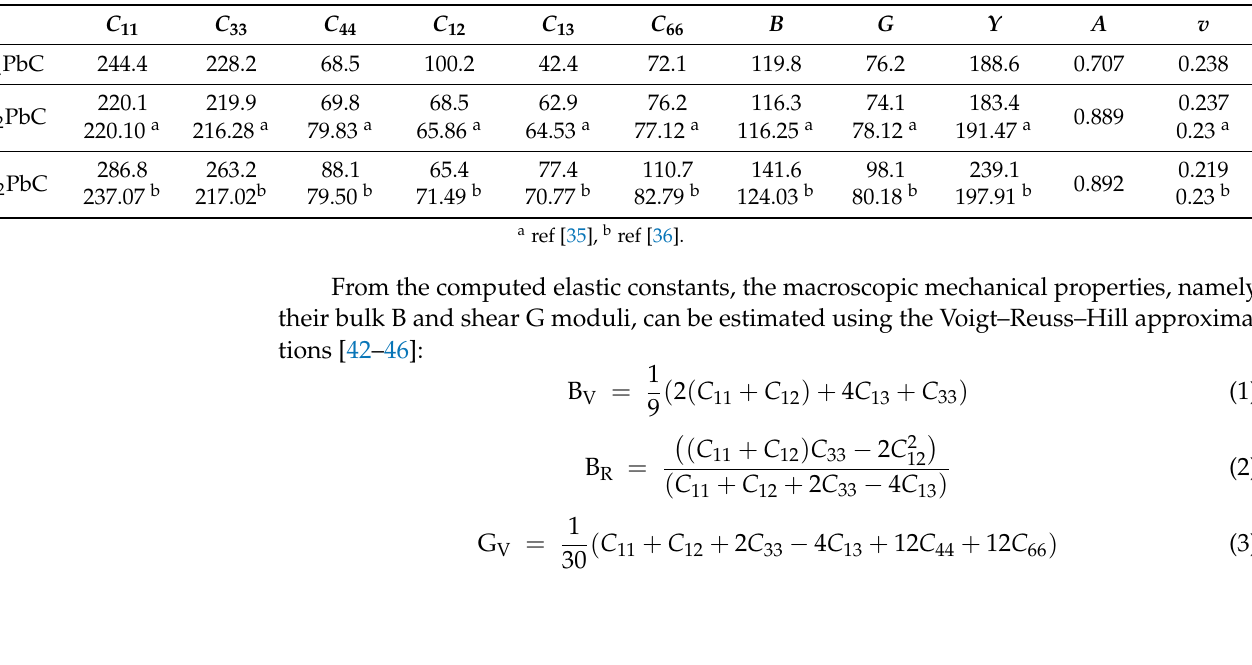
Figure 3. Variation in bond length ratio of M – Pb and M – C atoms of M 2 PbC; (M = Ti, Zr, Hf) MAX phase under pressure. Table 2. The predicted elastic constants, Cij (in GPa), bulk moduli (B, in GPa), shear moduli (G, in GPa), Young’s moduli (Y, in GPa), and Poisson’s ratio ( ν ) for Ti 2 PbC, Zr 2 PbC and Hf 2